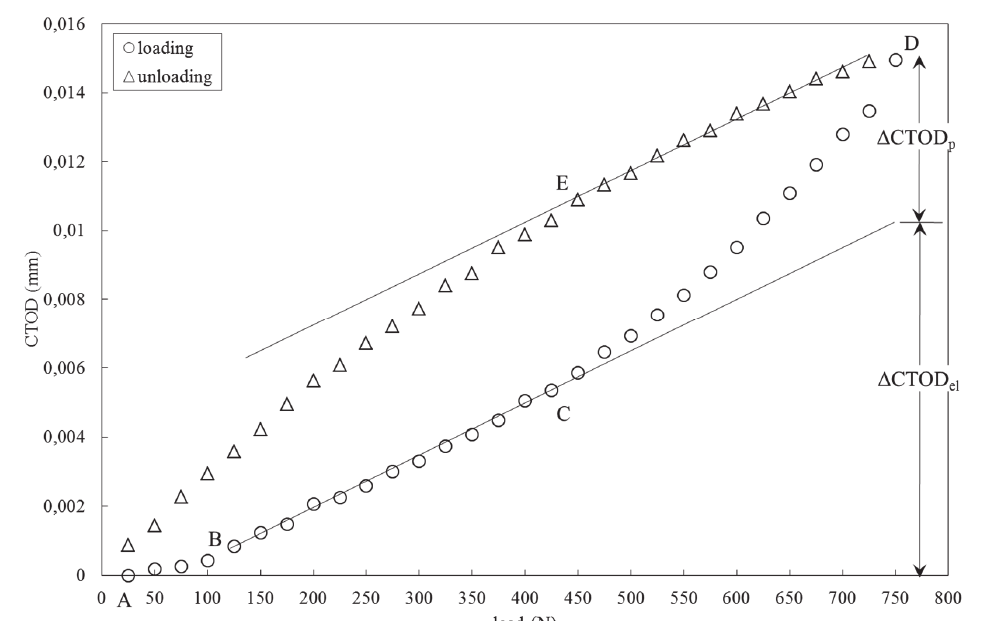
Figure 7: Plot of CTOD along a full loading cycle indicating its elastic and plastic components at a crack length of 9.40 mm using a L 1 value of 5 pixels and a L 2 value of 10 pixels.